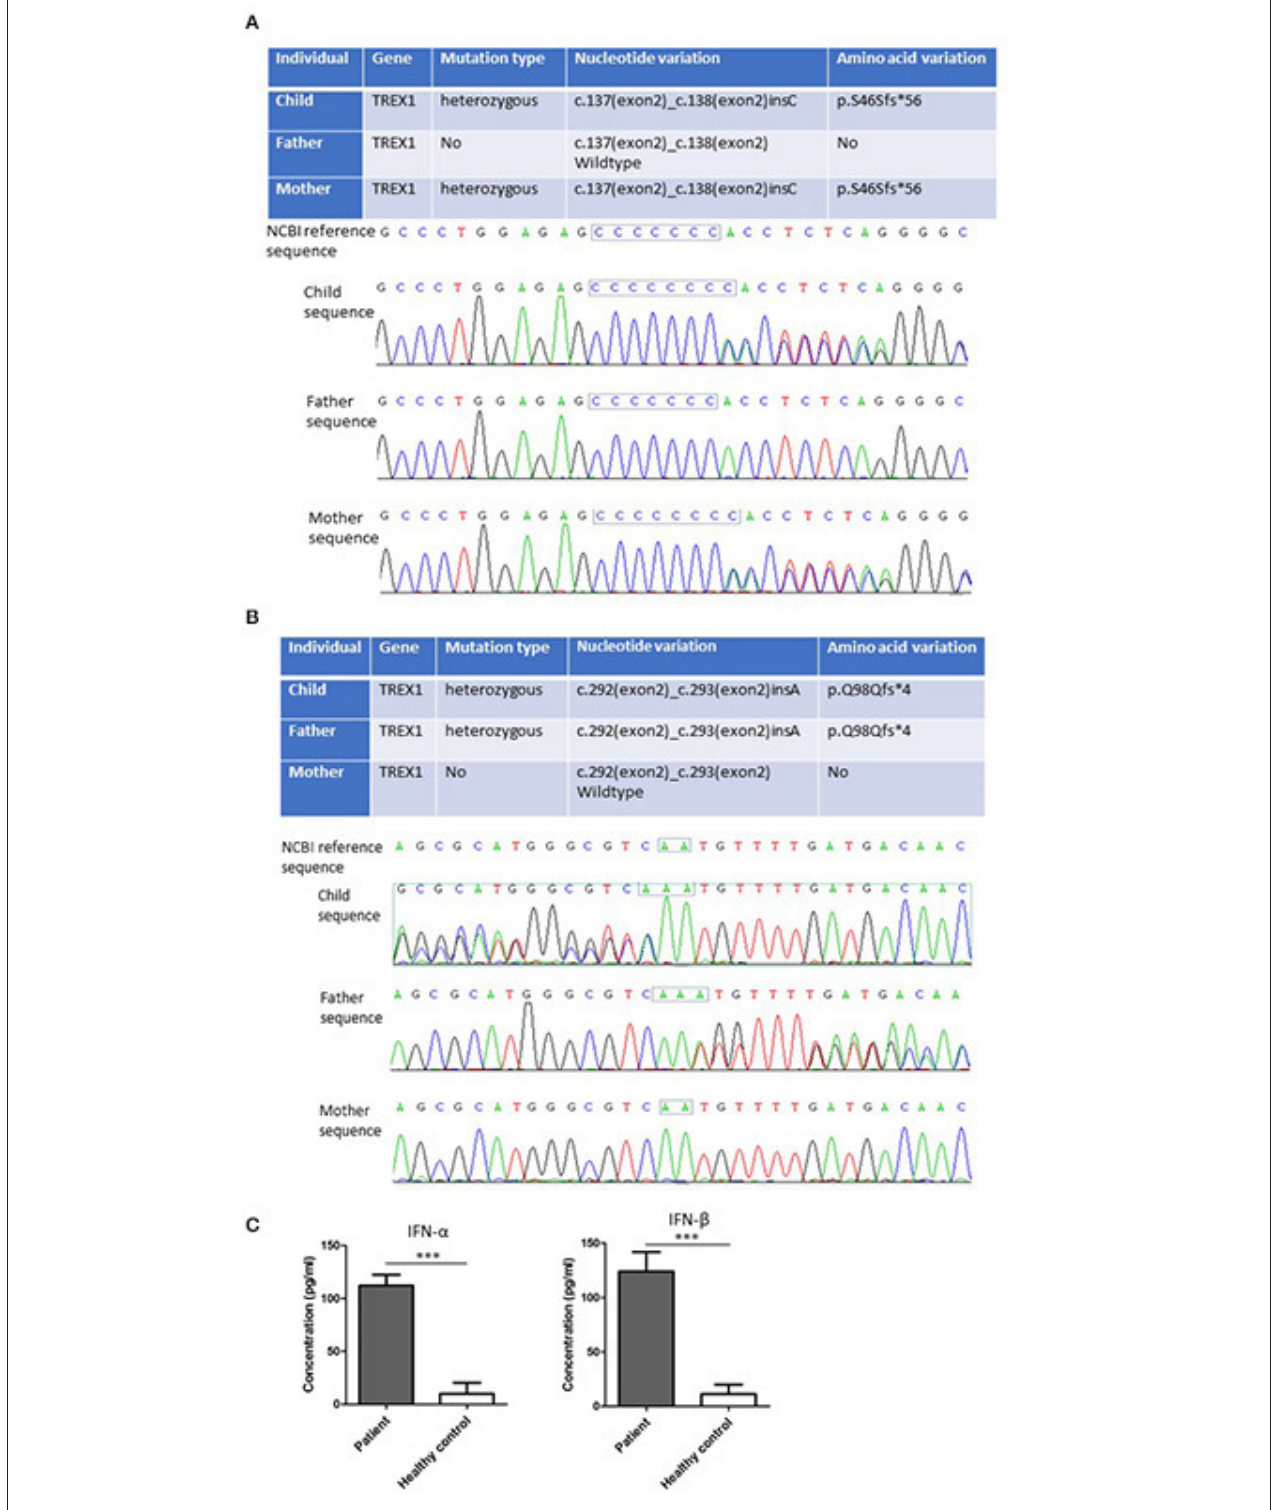
FIGURE 2 | Novel TREX1 mutations and elevated type I IFN were found in the patient. New mutations of c.137 (exon2)_c.138 (exon2) insC (A) and c.292 (exon2)_c.293 (exon2) insA (B) in TREX1 gene of the patient were detected by Trio-based whole-exome sequencing. (C) Increased IFN- α and IFN- β levels in the sera of the patient were detected by ELISA. Statistically significant differences are expressed as *** P < 0.001.